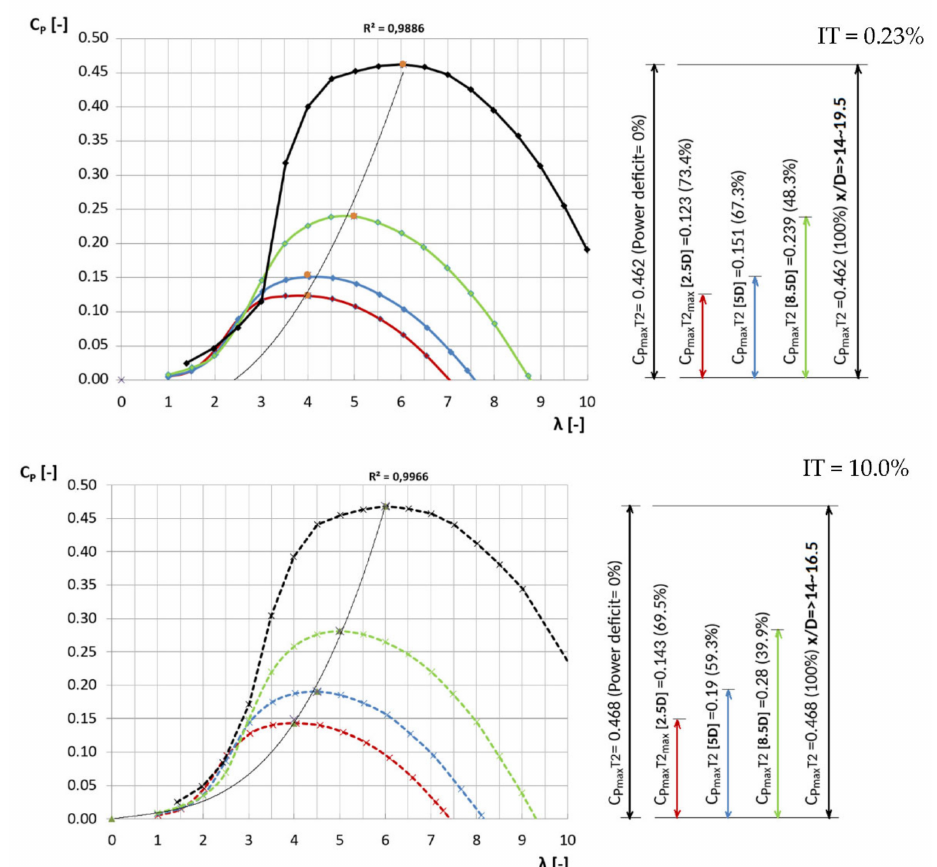
Figure 13. Cp_T2 characteristics for x/D = 2.5 (red), 5.0 (blue), 8.5 (green) and T1 in reference conditions (undisturbed flow, no T2, black). In parentheses—Cp_T2 deficit with respect to the reference; x/D indicates the predicted distance for full power recovery (see also Figure 14). IT = 0.23% ( top ) and 10% ( bottom ). In tandem cases, λ _T1 =